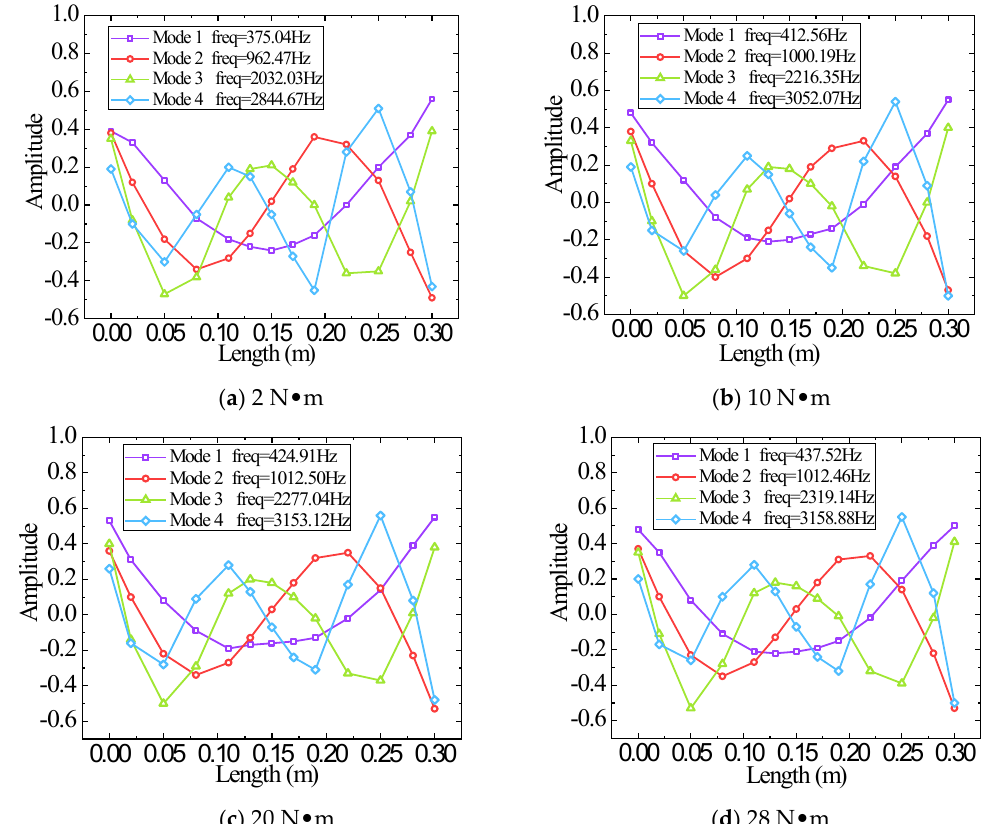
Table 5. Experimental damping ratio under different pre ‐ tightening torque.